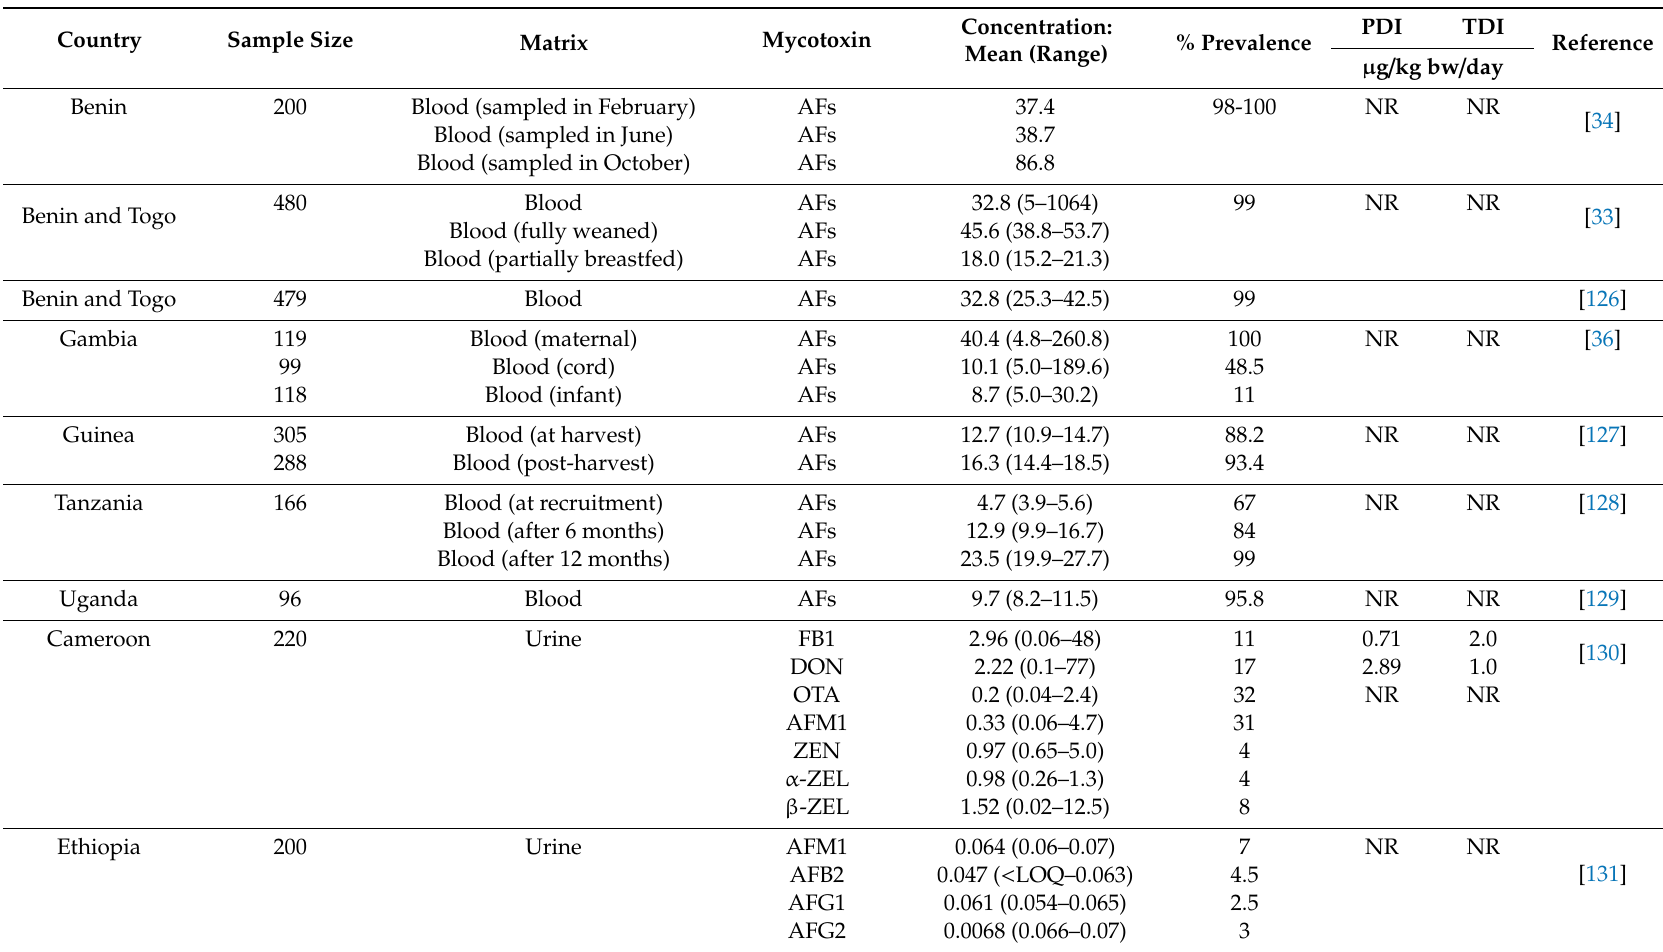
Table 4. Summary of mycotoxin exposure studies on infants and young children in sub-Saharan Africa using biomarkers (blood (pg / mg) and urine (ng / mL)).